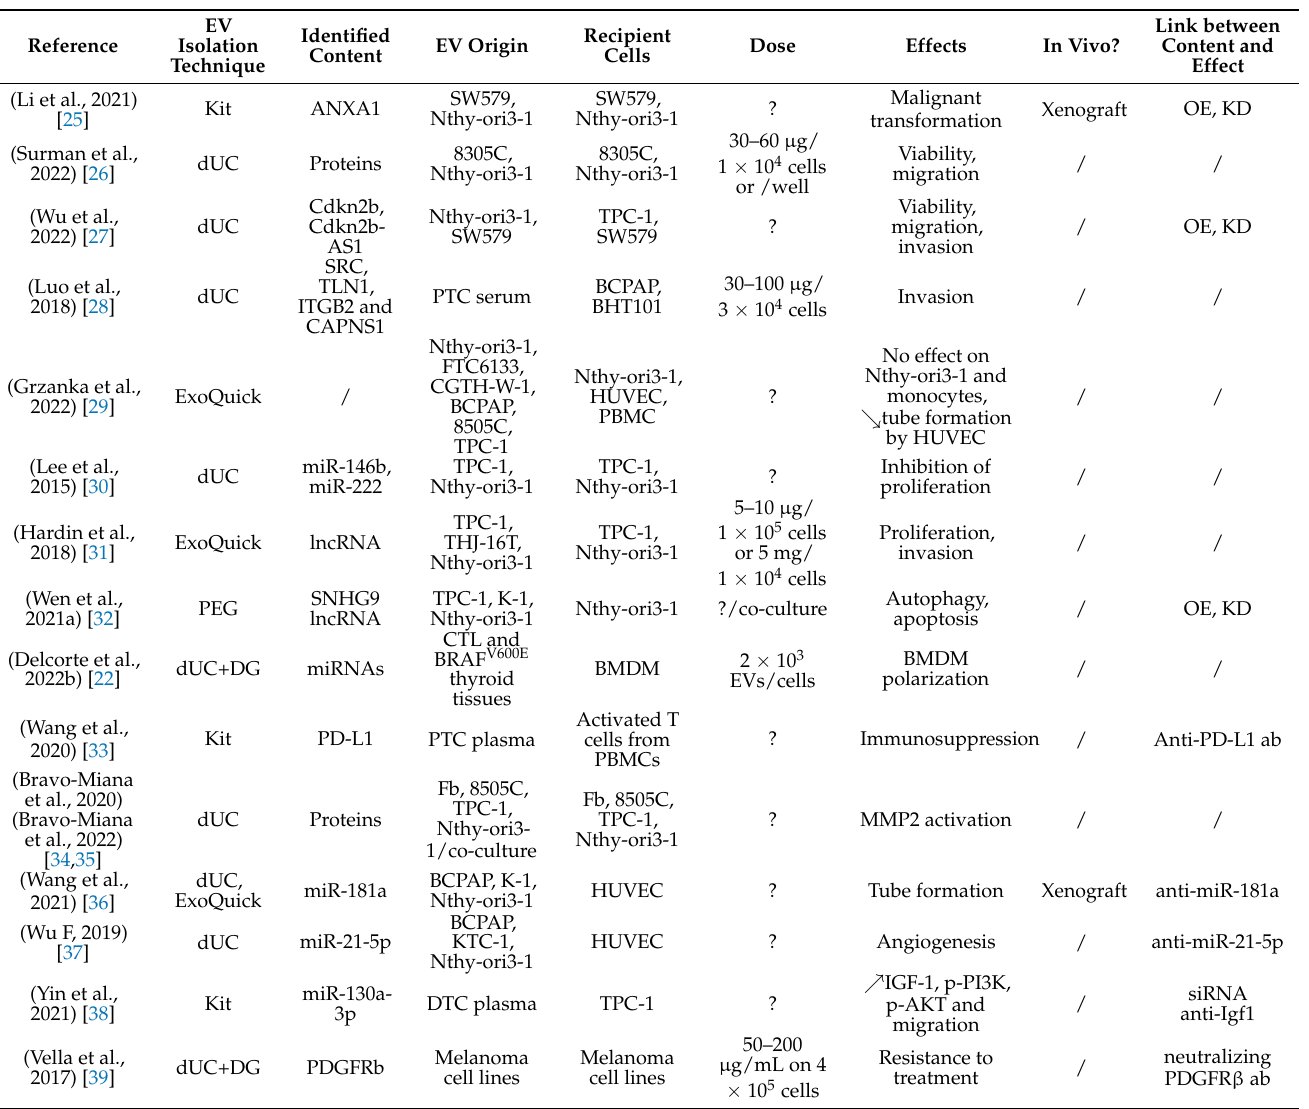
Table 1. List of publications analyzing the function of EVs in TC. Nthy—Nthy-ori 3-1; (d) UC—(differential) Ultra-Centrifugation; PEG—PolyEthylene Glycol; DG—Density Gradient; OE— OverExpression; KD—Knock Down;